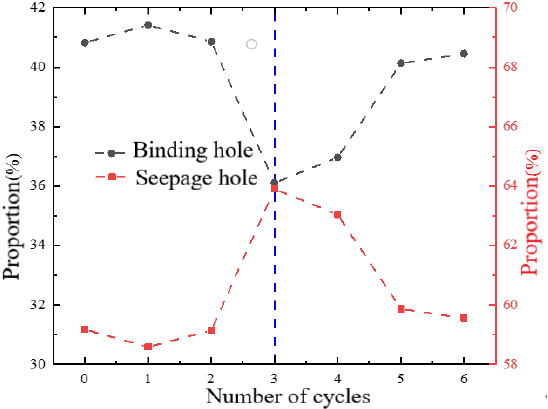
Figure 7. Evolution of bound pore and free pore proportions.